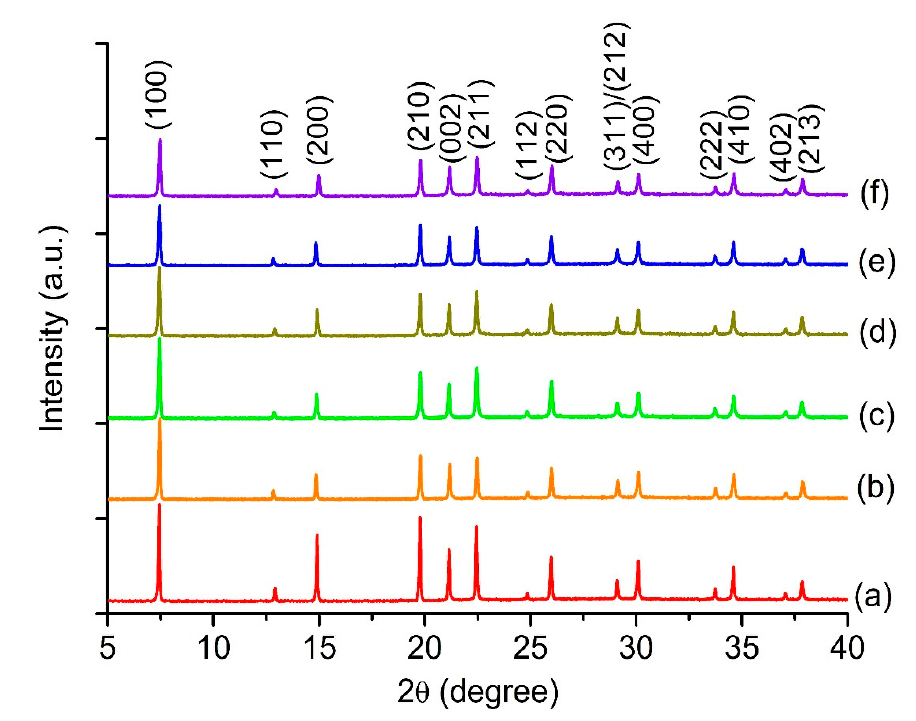
Figure 2. XRD patterns of ( a ) pristine SAPO-5, ( b ) CuCl x / SAPO-5, ( c ) CoCl x / SAPO-5, ( d ) SnCl x / SAPO-5, ( e ) FeCl x / SAPO-5 and ( f ) ZnCl x / SAPO-5.